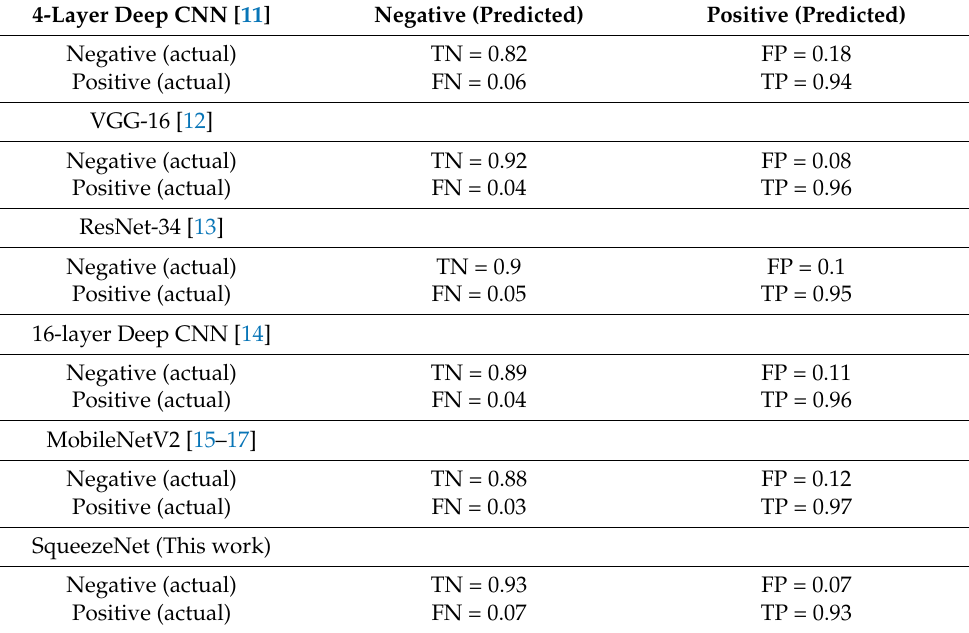
Table 8. Confusion matrix comparison with existing AI models with post-training weight quanti- zation on our dataset.